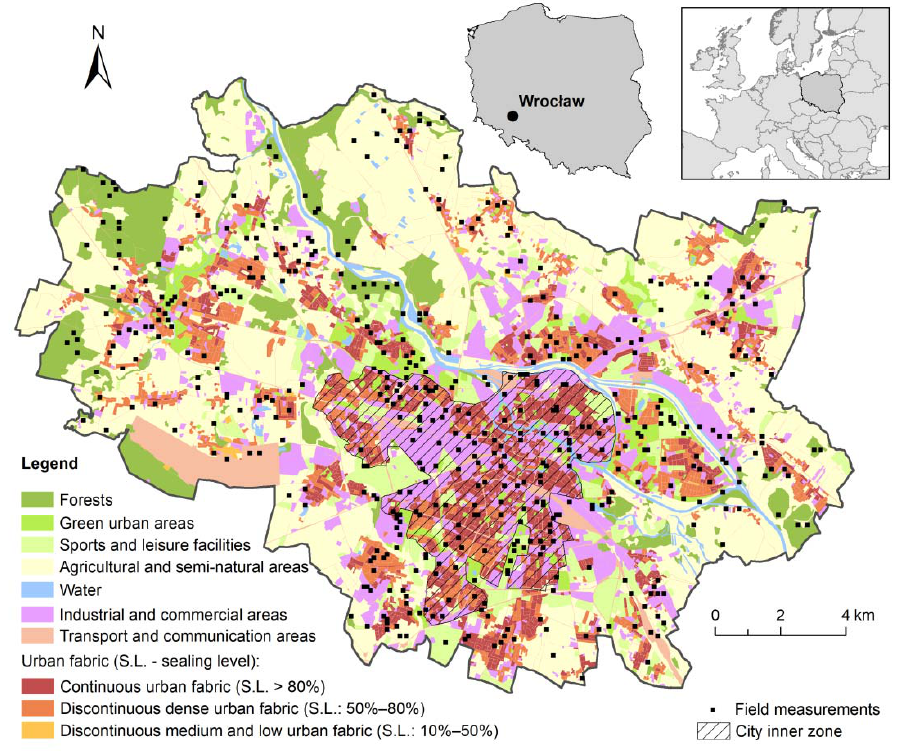
Figure 1. Urban landscape elements, land use, and the distribution of study plots in the city of Wroclaw area. The reader is referred to the online version of this article for interpretation of the contents expressed in color in this and further figures.